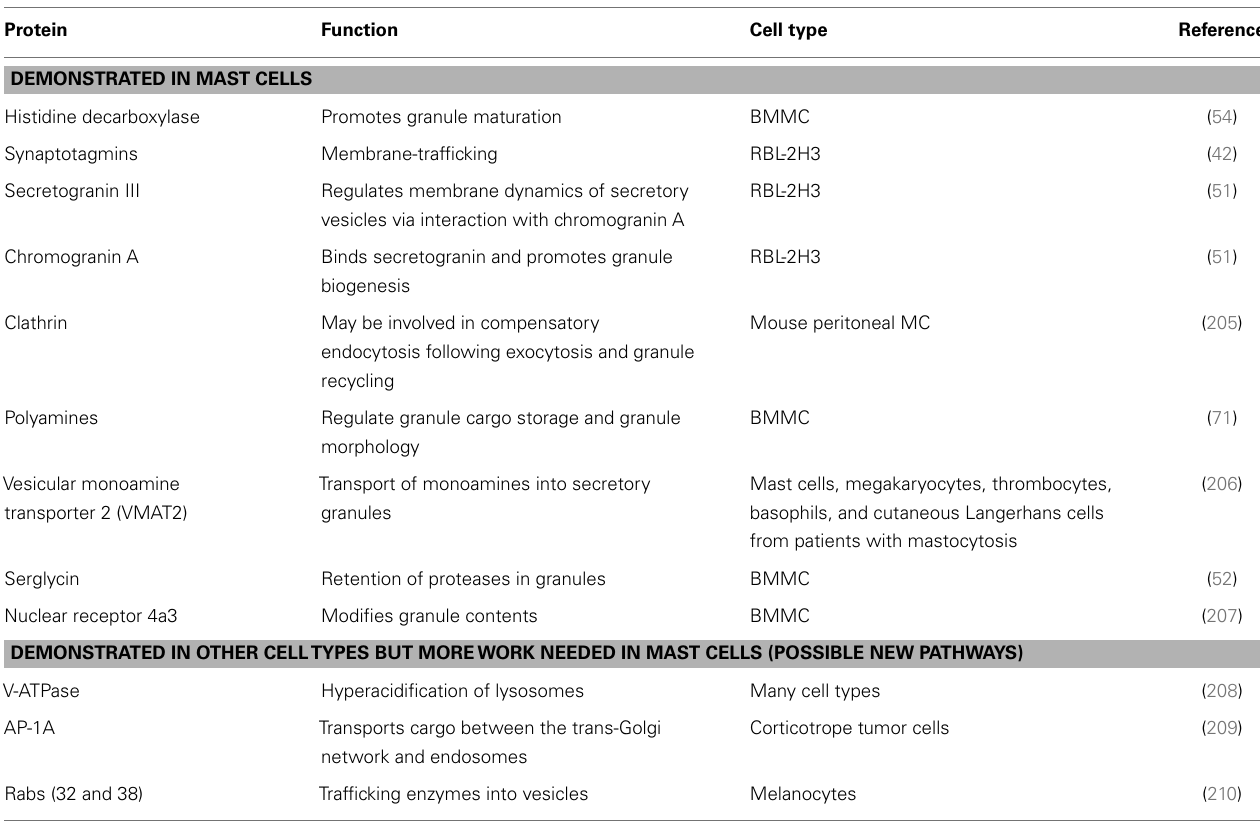
Table 4 | Molecules that are (or may be) involved in mast cell granule biogenesis and homeostasis .